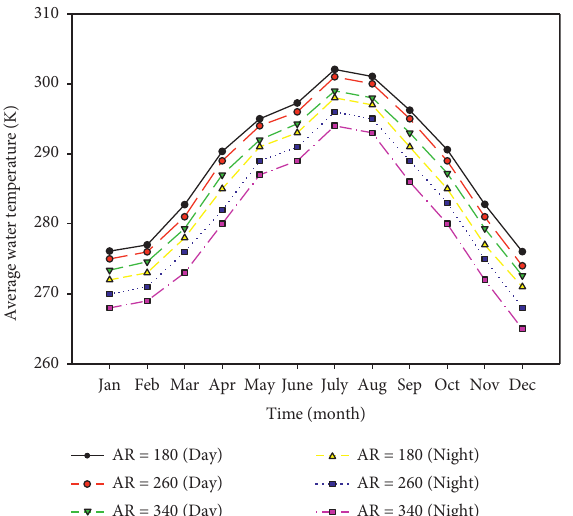
Figure 6: Effect of aspect ratio on average water temperature for reactor inclined at 1 ° , Re � 9000, and water depth �